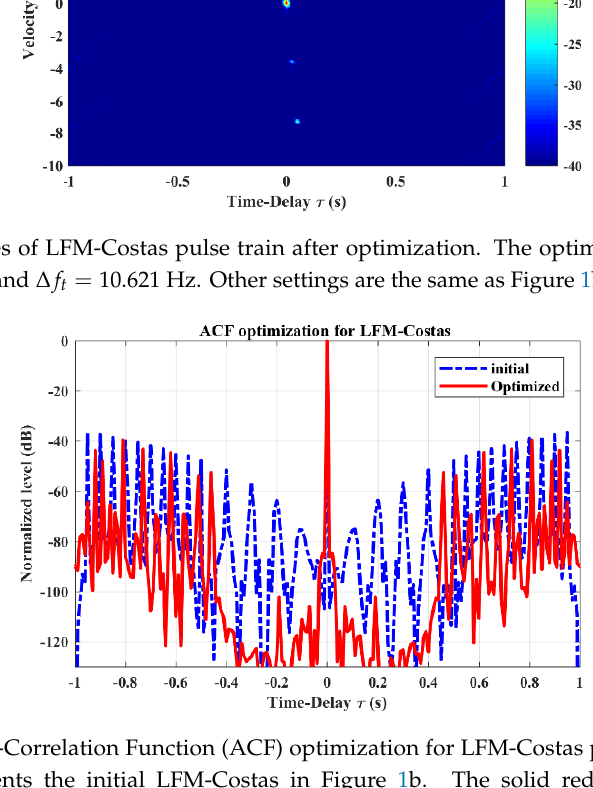
Figure 3. AF shapes of LFM – Costas pulse train after optimization. The optimized parameters are  = and 10 . 621 H z f  = . Other settings are the same as Figure 1b. 391 . 9 H z / 94 s t t